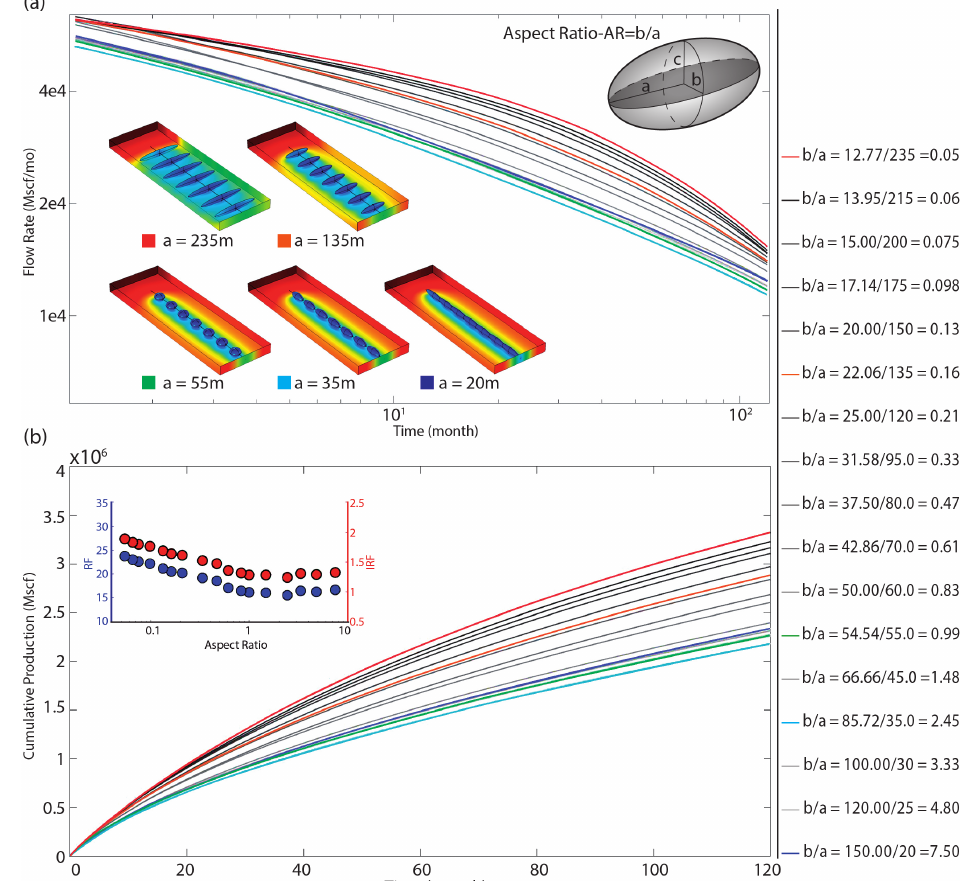
Figure 8. Impact of EPV geometry. Flow rate production of methane in log-log scale. The snap- shots represent the BCa field pressure at the end of the well life for different lengths of the a axis. Each of them corresponds to an AR value ( a ). Cumulative production of methane in log-log scale. ( b ) Ten year simulation. Pressure field colormap takes the value range that appears in the Figure